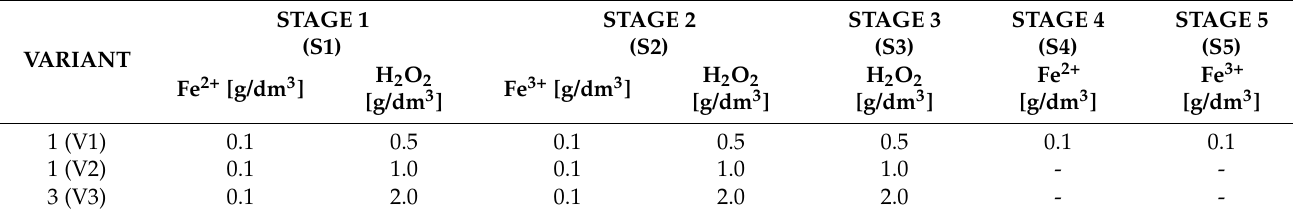
Table 1. Chemical reagent doses used in the